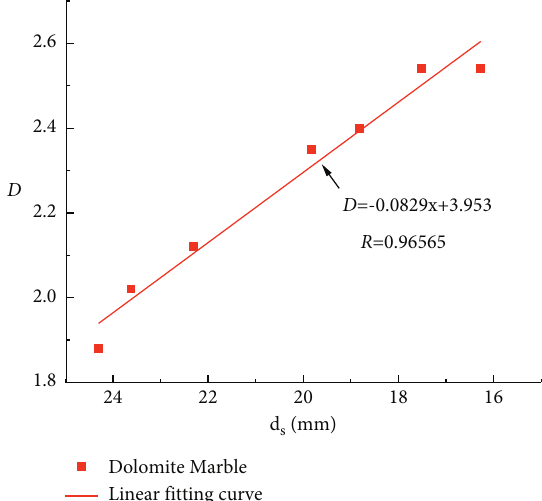
Figure 9: Relationship between the fractal dimension and the average fragmentation